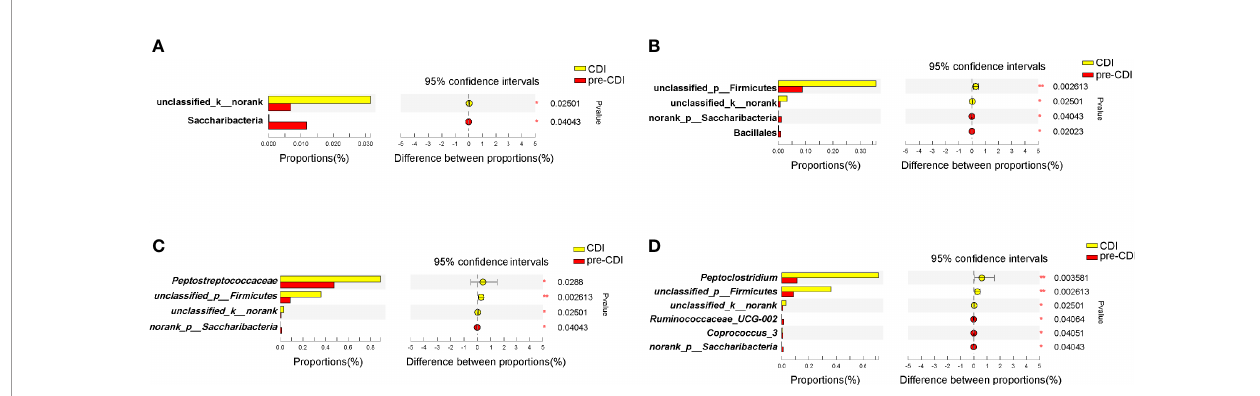
FIGURE 5 | Taxonomic differences of fecal microbiota between the CDI and pre-CDI samples. Comparison of relative abundance proportions at the bacterial phylum (A) , order (B) , family (C) and genus (D) levels *P < 0.05; **P